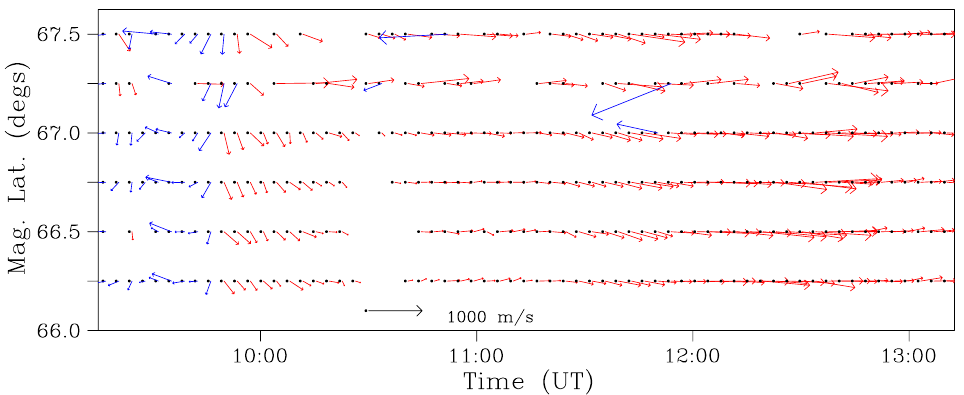
Fig. 1. Convection pattern estimated from PFISR incoherent scatter data. The horizontal axis represents UT=LT+9h. The convection reversed from westward to eastward at about 09:45UT. Velocity estimates with relative errors less than 25% and absolute errors less than 200m/s are plotted. A few outliers remain, such as the spurious “reversal” just prior to 12:00UT.